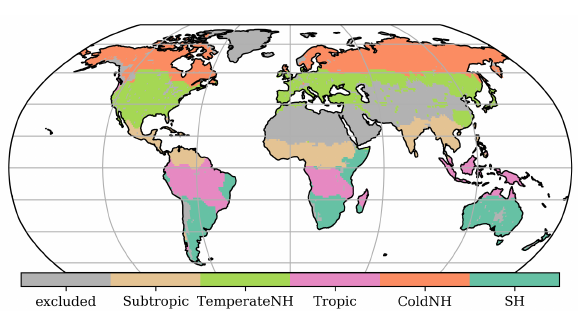
Figure 1. The masked out cells (‘excluded’) and the bioclimatic regions used for model evaluation: Cold Northern Hemisphere (‘ColdNH’), Temperate Northern Hemisphere (‘TemperateNH’), ‘Tropic’, ‘Subtropic’ and remaining Southern Hemisphere regions (‘SH’).